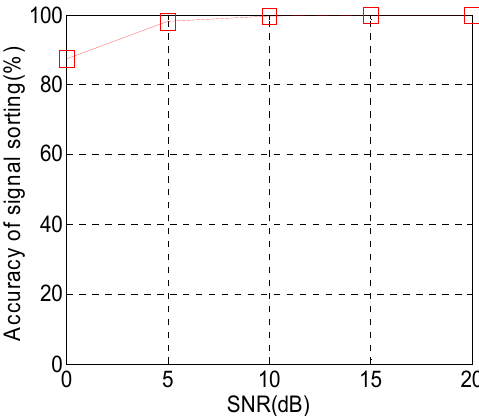
Figure 12. Accuracy of signal sorting in different SNRs.